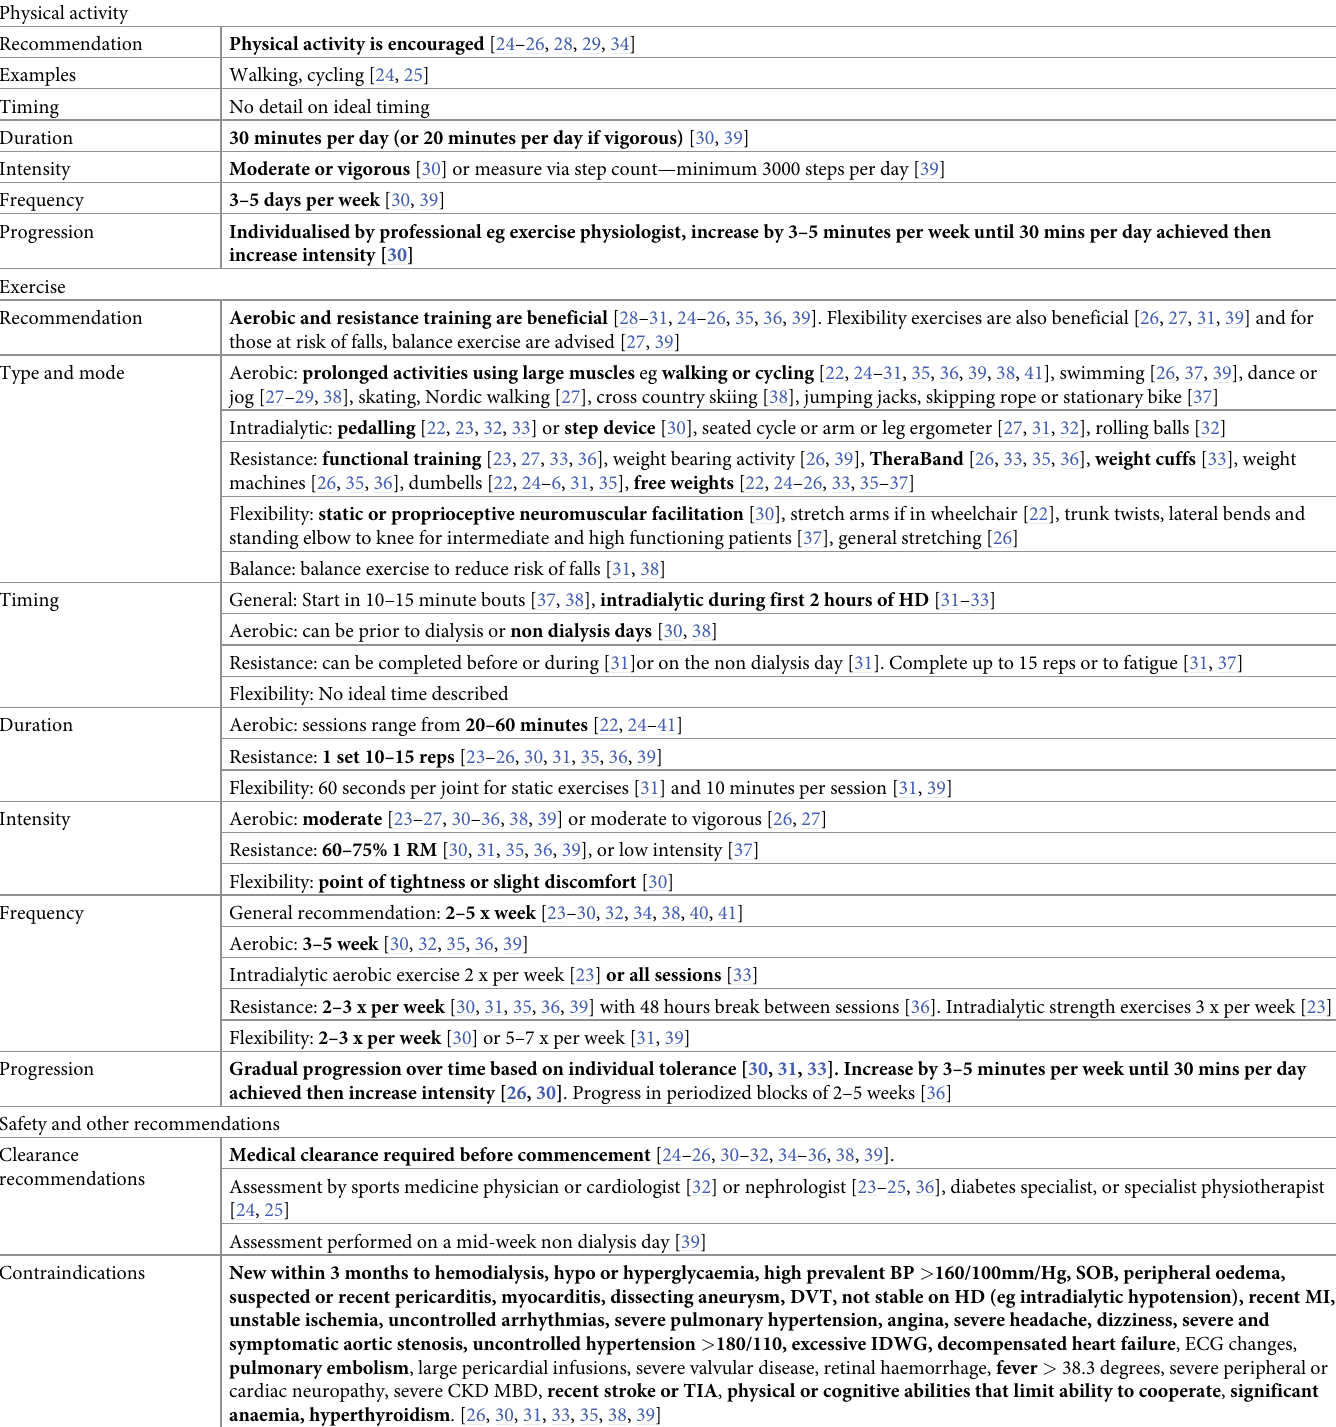
Table 2. Summary of recommendations about physical activity and exercise obtained from papers retrieved in scoping